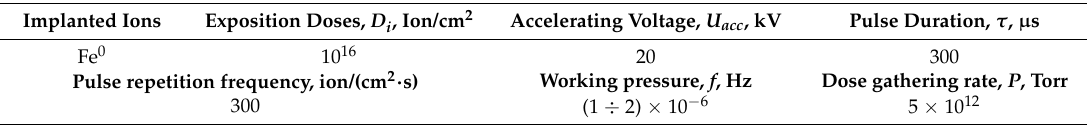
Table 1. Conditions of ion implantation of the polypropylene (PP)